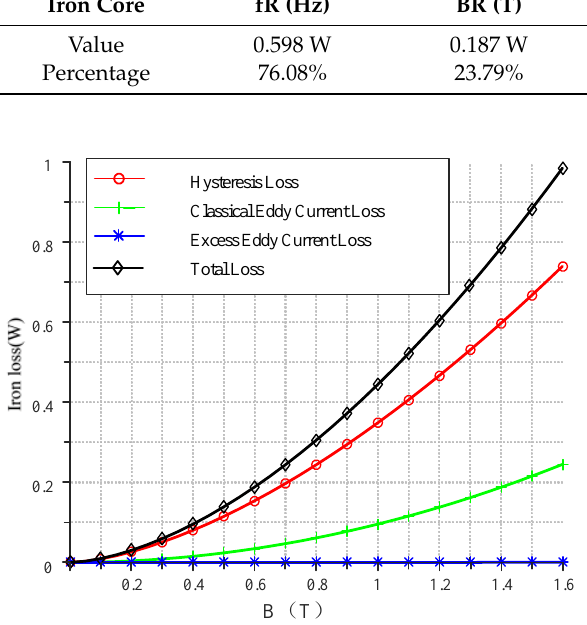
Figure 9. Hysteresis loss curve, classical eddy current loss curve, and excess eddy current loss curve in the AMB versus magnetic magnitude. Table 5. Main parameters and loss calculation results of the AMB.